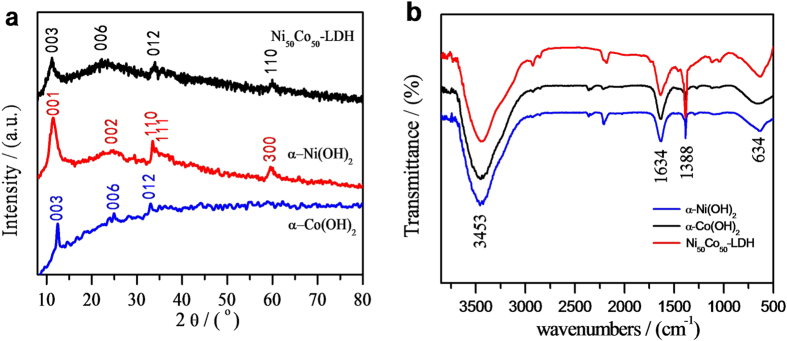
(a) XRD patterns and (b) FT-IR spectra of the Ni50Co50-LDH and α-Ni(OH)2 and α-Co(OH)2.